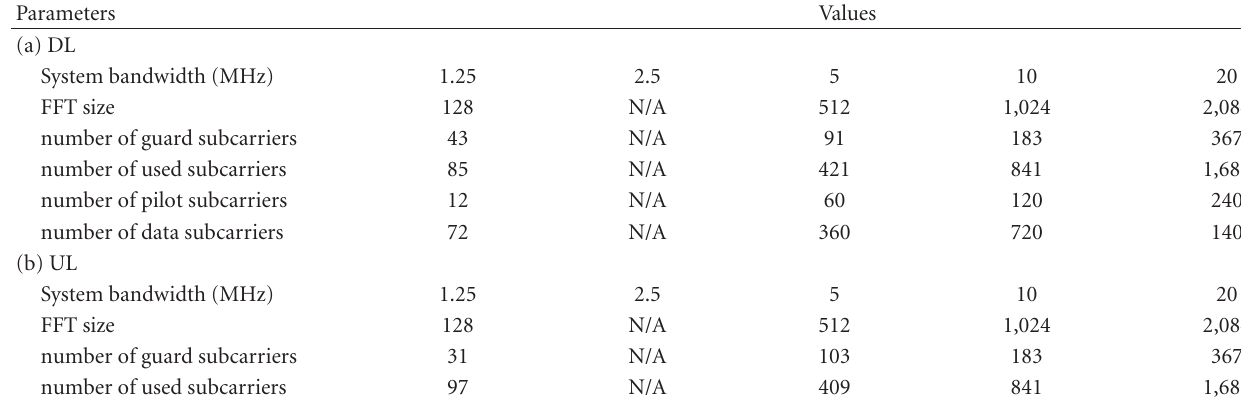
Table 2: Number of subcarriers in PUSC [8].